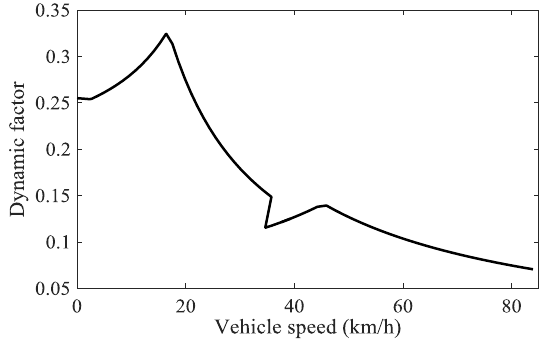
Figure 7. Dynamic factor of the hybrid HDV without SOC.